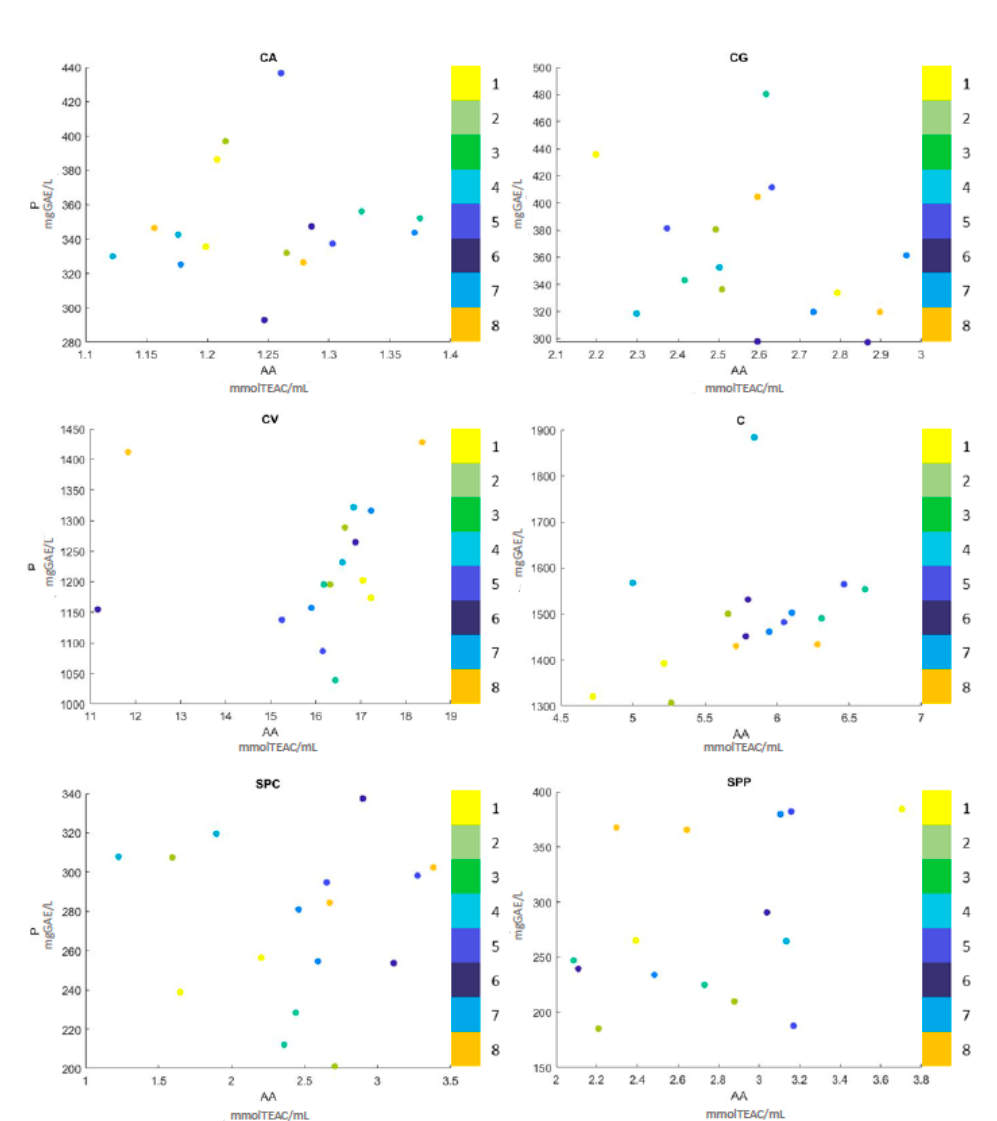
Figure 6. Results obtained for antioxidant activity (AA) and polyphenol content (P) divided by substrate. The spectrum shows the colors corresponding to each combination.